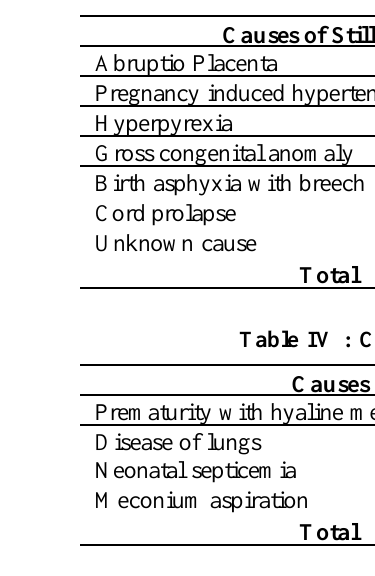
Table III : Causes of still birth